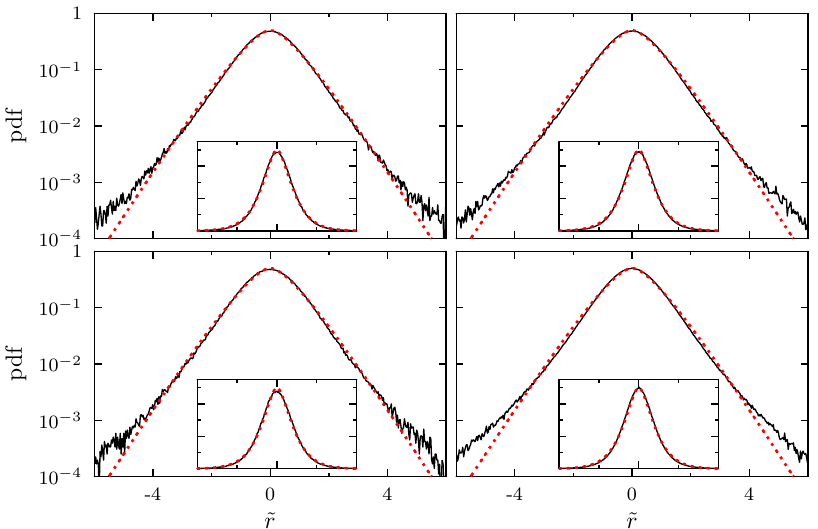
Figure 6. Aggregated distribution for the normalized monthly returns with the effective correlation matrix on a logarithmic scale. The black line shows the empirical distribution; the red dotted line shows the theoretical results. The insets show the corresponding linear plots. Top left/right: S&P 500 (1992–2012)/(2002–2012); bottom left/right: NASDAQ (1992–2012)/(2002–2012). The average correlation coefficients are c = 0.26, 0.35, 0.21 and 0.25, respectively. Reproduced with permission from (Schmitt et al. 2015), Infopro